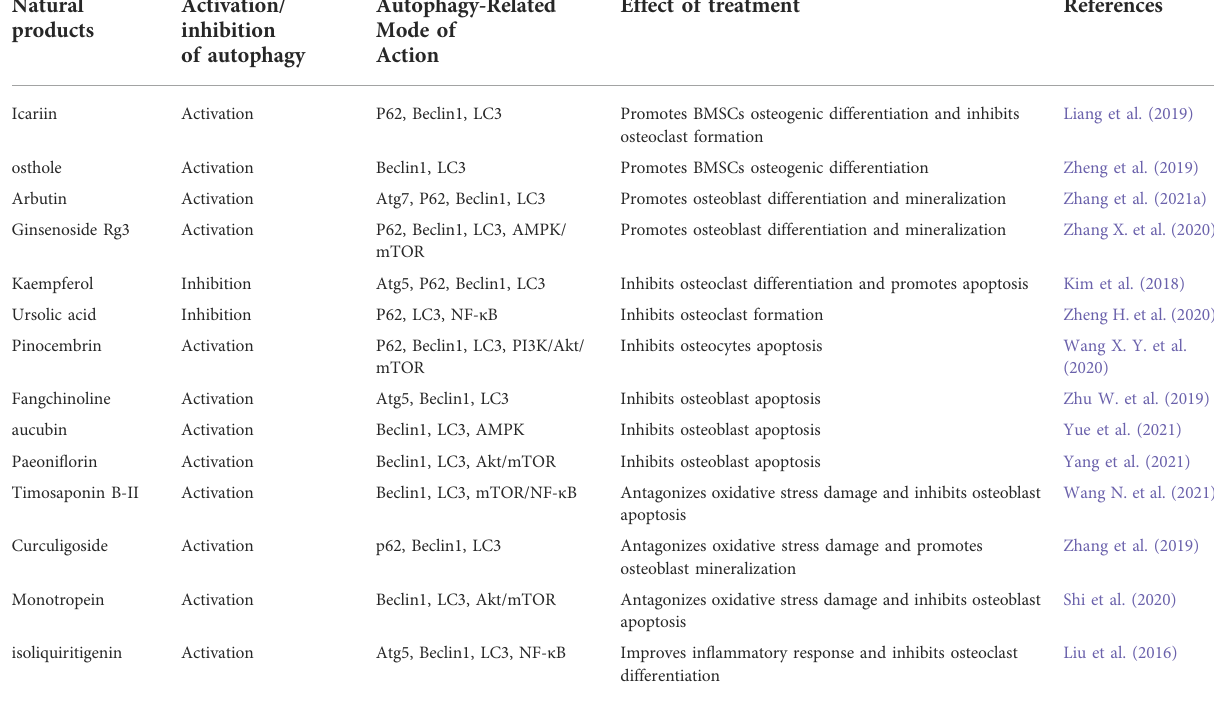
TABLE 1 Natural products for the treatment of OP by targeting